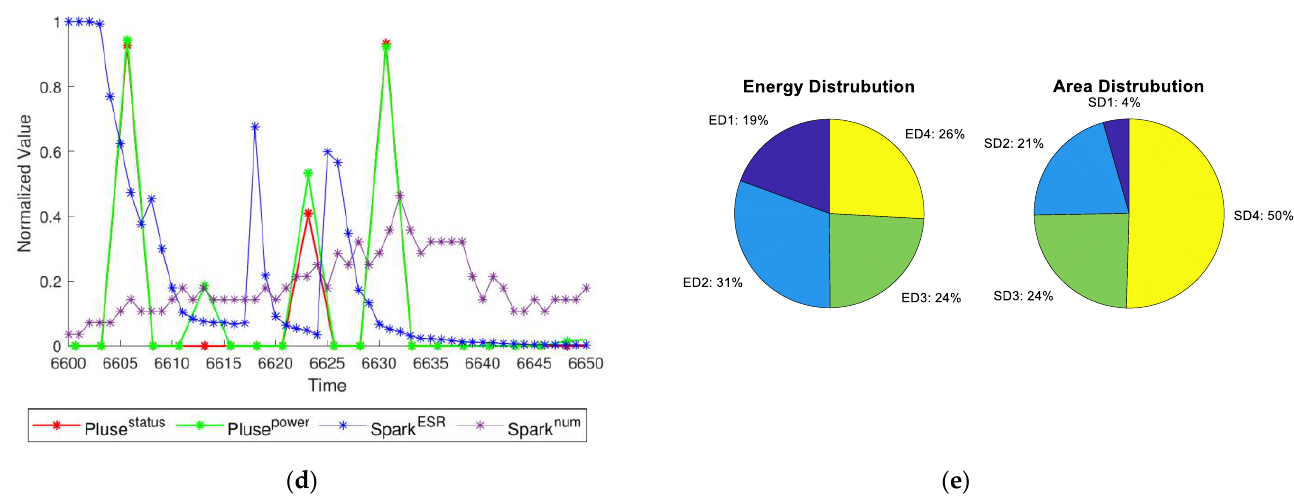
Figure 15. Multiple sparks process (under the condition of trial 1): ( a ) image time series of machining process (180 frames); ( b , c ) combine image with normalization or binarization; ( d ) pulse waveform and spark features; ( e ) energy and area distribution.